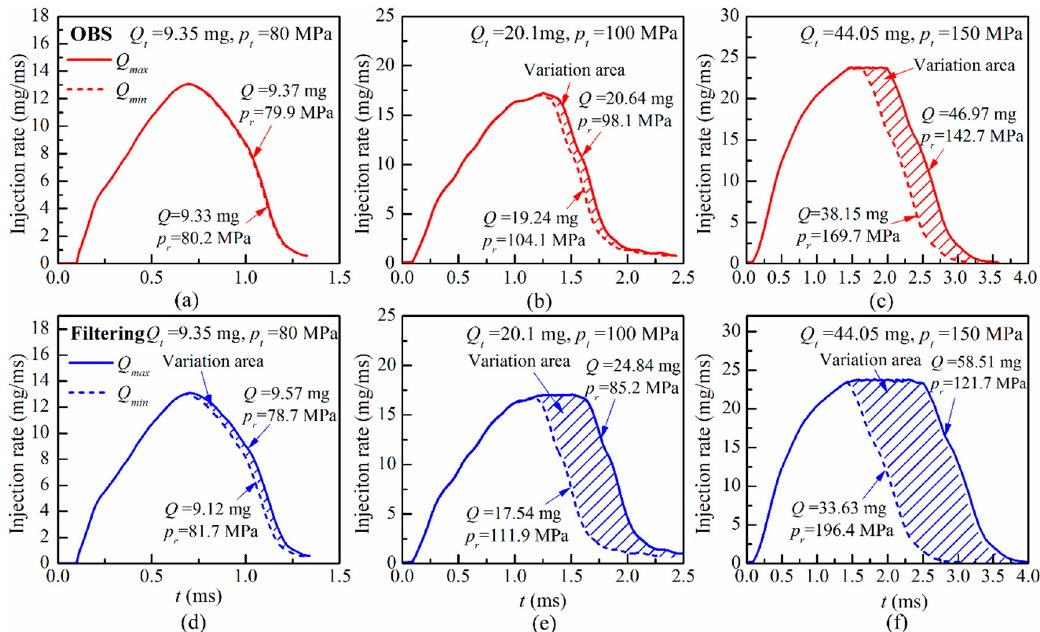
Figure 9. Measured injection rate of Q max and Q min in 200 cycles under the OBS method, shown in ( a – c ), and conventional filtering method, shown in ( d – f ), for three different target pressures.